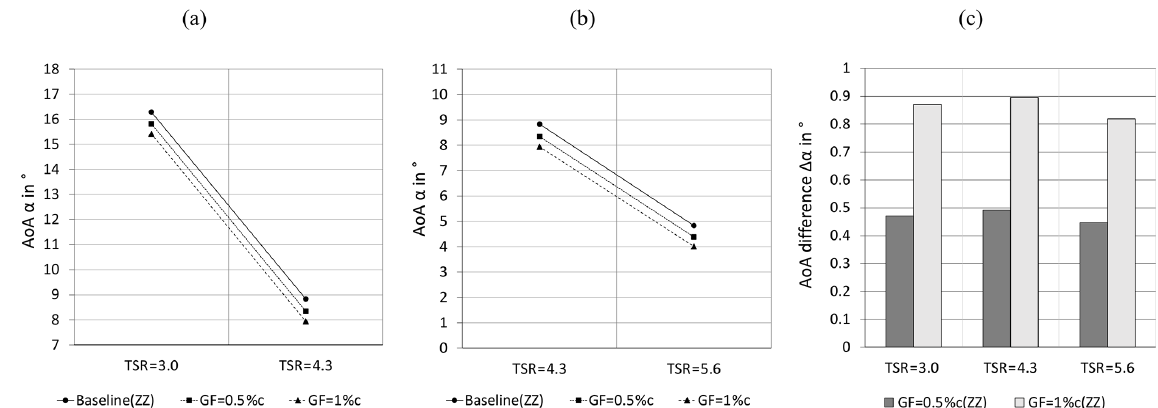
Figure 8. Angles of attack in the tripped case at r = 0.56 R and ϕ = 270 ◦ . (a) Stall and rated conditions. (b) Rated and feather condi- tions. (c) AoA difference between Gurney flap configurations and the